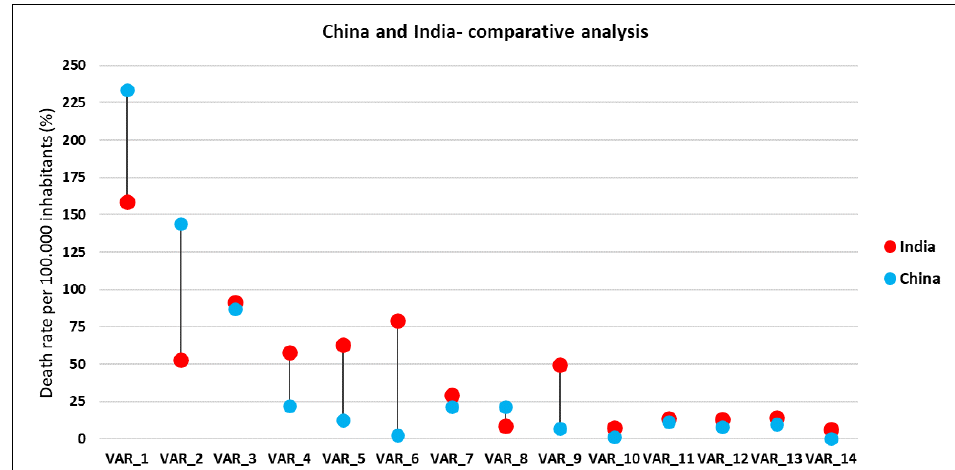
Figure 6. Comparison of the death rate per 100.000 inhabitants between China and India by cause of death (average 1990–2017). Source of data: The Institute for Health Metrics and Evaluation, World